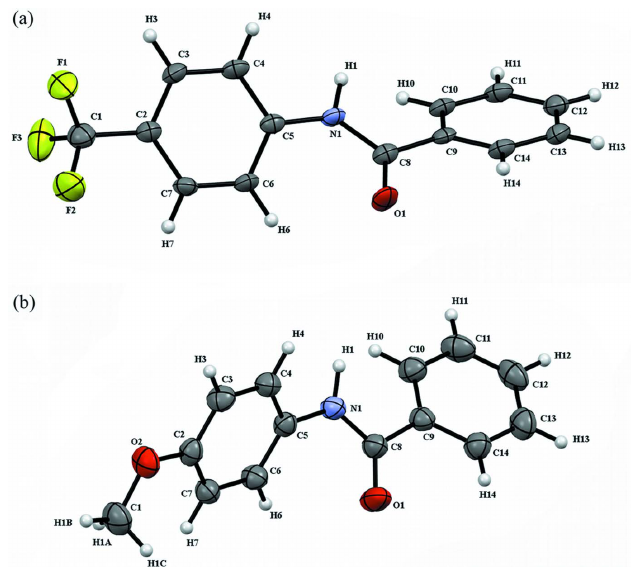
Figure 1 The molecules present in the asymmetric units in ( a ) TFMP and ( b ) MOP . Displacement ellipsoids are drawn at the 50% probability level. Hydrogen atoms are represented by spheres of 0.20 A˚